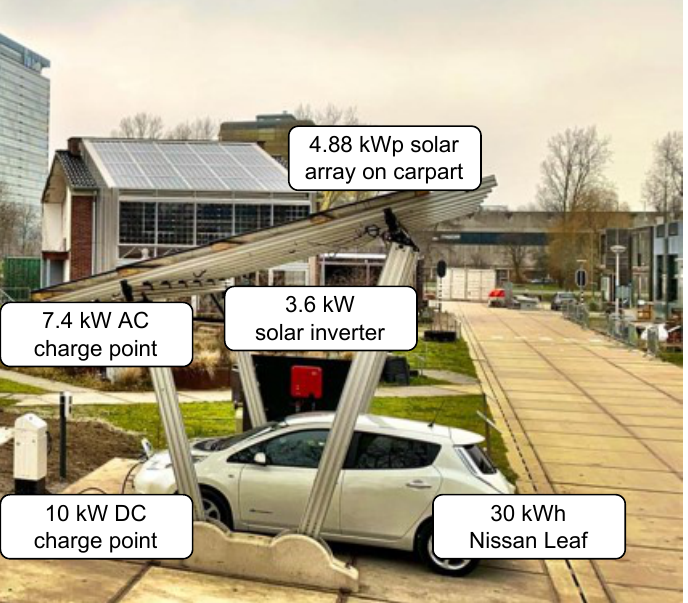
Figure 3. The V2G test set-up at the solar carport located at the Green Village, TU